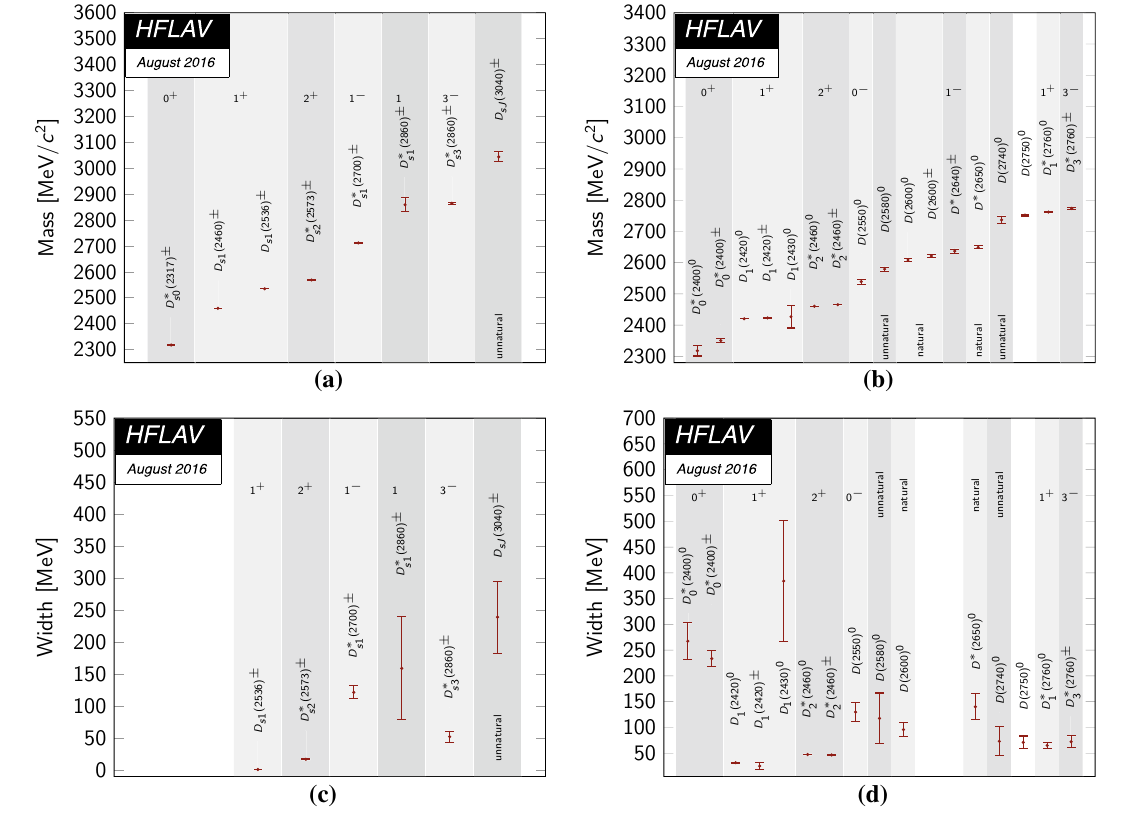
Fig. 213 Averaged masses for excited D s mesons are shown in ( a ) and for D mesons in ( b ). The average widths for excited D s mesons are shown in ( c ) and for excited D mesons in ( d ). The vertical shaded regions distinguish between different spin parity states